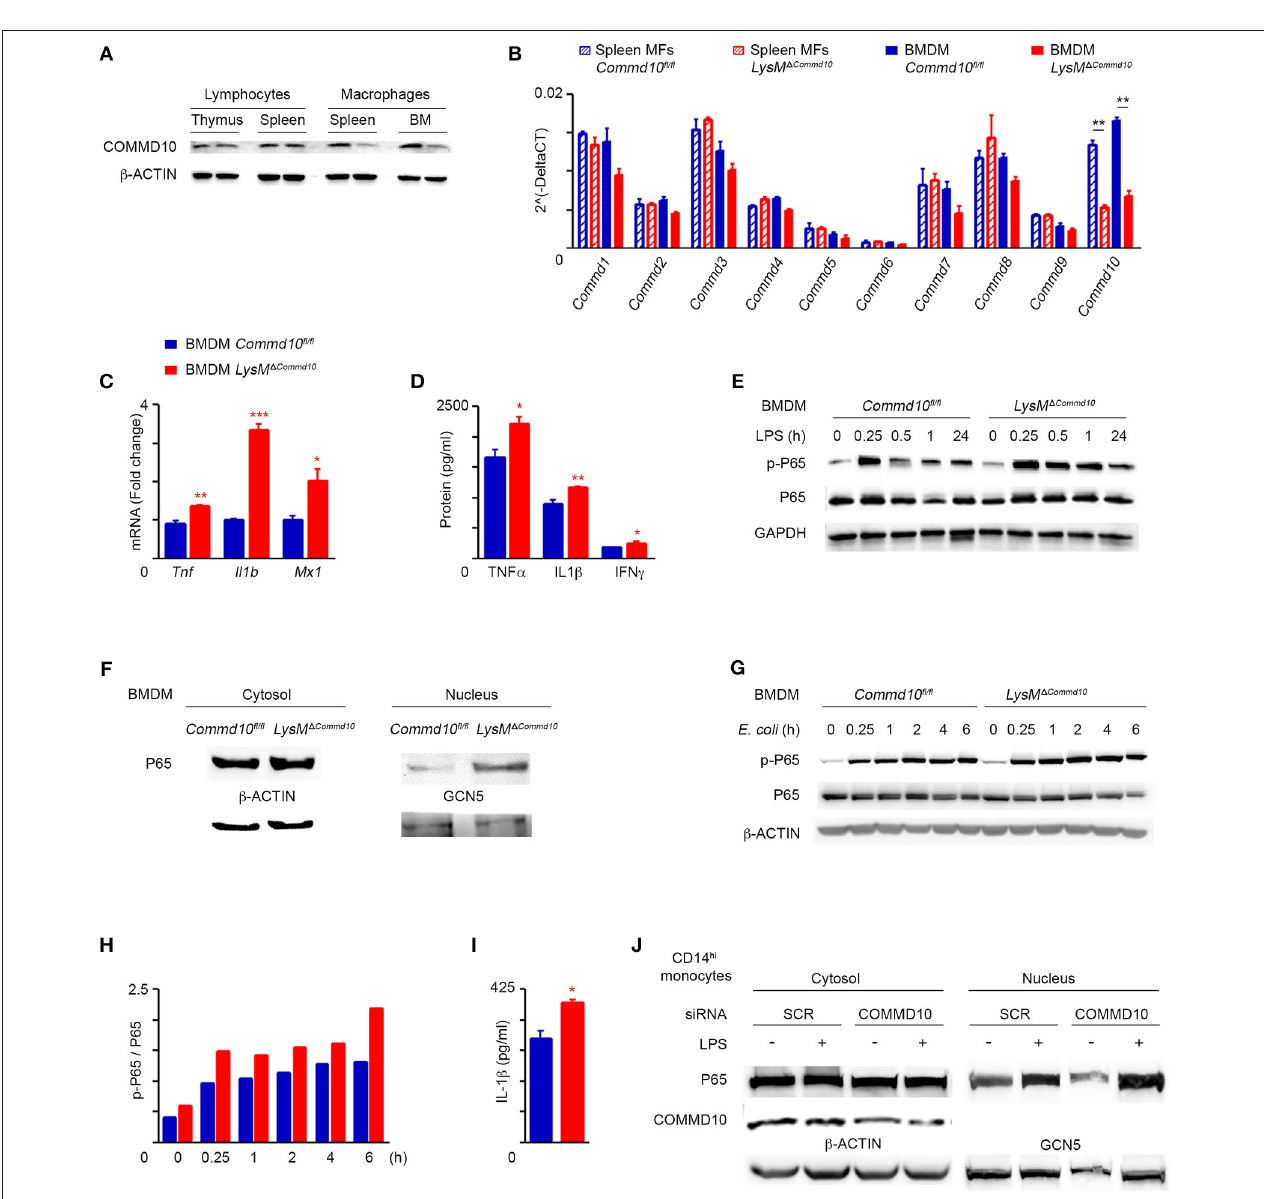
FIGURE 1 | LysM 1 Commd 10 BMDM respond to LPS by higher production of pro-inflammatory cytokines. (A,B) Cells were isolated from spleen and BM of Commd10 fl / fl (blue) or LysM 1 Commd 10 (red) mice. (A) Immunoblots showing the expression of COMMD10 in cell lysates of thymic or splenic lymphocytes vs. splenic or BM-derived macrophages. β -actin was utilized as control. (B) qRT-PCR gene expression of all COMMD family members in splenic macrophages and BMDM ( n = 3). (C,D) BMDM were stimulated with LPS (100ng/ml) for 3h. (C) qRT-PCR gene expression of pro-inflammatory cytokine in cell lysate ( n = 3). (D) ELISA of pro-inflammatory cytokine levels in cell free supernatants ( n = 3). (E) Representative immunoblot of BMDM cell lysates following LPS challenge (100ng/ml) showing the protein expression of phospho-P65 (p-P65) and P65 over time course. GAPDH was used as control. (F) Immunoblots showing P65 expression in cytosolic and nuclear fraction lysates of LPS-treated BMDM. β -ACTIN and Polymerase II antibodies, respectively, were used as controls ( n = 3). (G–I) BMDM from Commd10 fl / fl or LysM 1 Commd 10 mice were infected with E. Coli at multiplicity of infection (MOI) = 1. (G) Immunoblots showing the protein expression of p-P65 and P65 over time course. β -ACTIN was used as control. (H) Respective densitometry-based quantification of p-P65/P65 ratio in Commd10 fl / fl vs. LysM 1 Commd 10 BMDM over time course following E. coli infection. (I) ELISA analysis of IL-1 β from supernatants at 6h post-infection with E. coli ( n = 4). (J) Immunoblots showing cytosolic COMMD10 protein expression following siRNA-based gene silencing vs. scrambled siRNA control, β -ACTIN was used as control, and immunoblots showing P65 expression in cytosolic and nuclear fraction lysates of LPS-treated human CD14 hi monocyte-derived macrophages. GCN5 was used as control in the nuclear fraction ( n = 3). Data were analyzed by unpaired, two-tailed t- test, comparing each time between Commd10 fl / fl and LysM 1 Commd 10 (red stars), and are presented as mean ± SEM with significance: * p < 0.05, ** p < 0.01, *** p < 0.001. Data in (A,B,E) represents two-independent experiments. Data in (C,D,F–J) are from a single experiment.